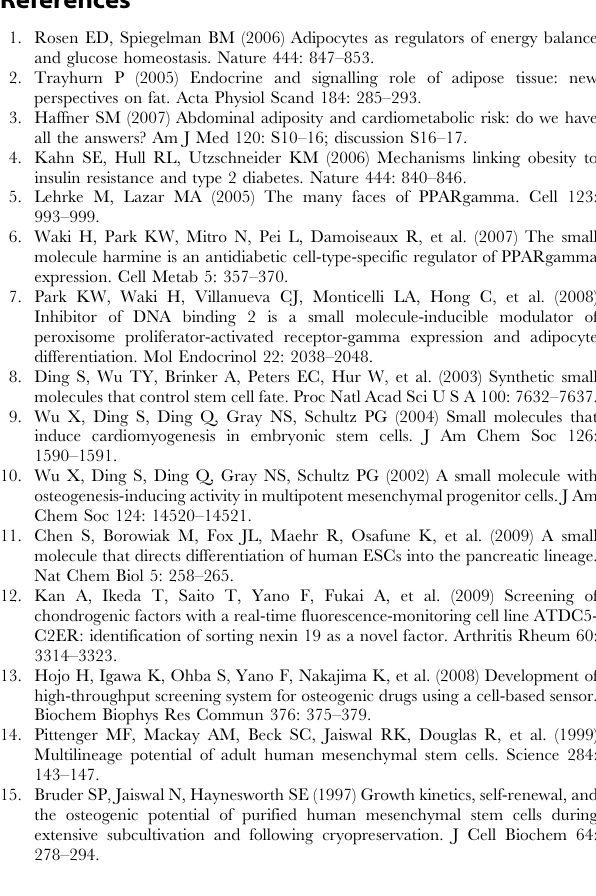
through the fluorescence microscope. Bar= 50 m m. Figure S2 a, Normalized mRNA expression of aP2 gene determined by real-time PCR during adipogenesis; b, Fluores- cence intensity detection of aP2-hrGFP hMSCs by fluorescence spectrophotometer during normal adipogenic induction; c, Cell Titer Glo assay of D0, D15 and D18 adipogenic differentiated cells; d and e, Oil red O staining of D15 and D18 differentiated cells. Data are presented as mean 6 SD of three independent experiments, and the p-values in the graph show the statistical significance of the difference between each test day and the D0 control group. ( w p , 0.05; ww p , 0.01); Bar =50 m m. Found at: doi:10.1371/journal.pone.0013014.s002 (2.35 MB TIF) Figure S3 Cell Titer Glo assay of D0 and D15 adipogenic differentiated cells. Data are presented as mean 6 SD of three independent experiments, and the p-values in the graph show the statistical significance of the difference between D0 and D15 differentiated cells. ( w p , 0.05; ww p , 0.01). Found at: doi:10.1371/journal.pone.0013014.s003 (4.10 MB